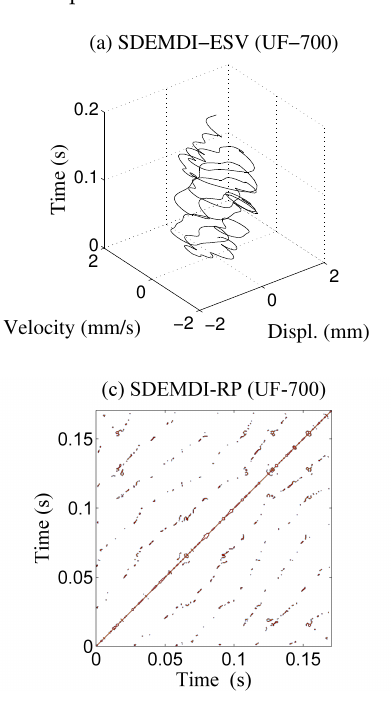
Figure 14. ( a ) Evolution of state variables; ( b ) phase plane; ( c ) recurrence plot for Case 2 at 700